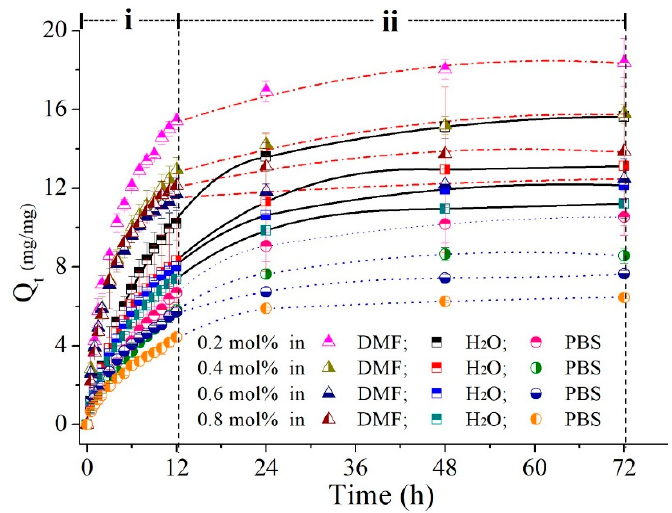
Figure 6. Dynamic swelling profiles of poly(MEO 2 MA) hydrogel samples measured in DMF, Milli-Q water, and PBS at constant temperature of 4 °C for 72 h, respectively.